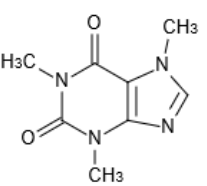
Figure 1. Caffeine chemical structure. Figure 1. Ca ff eine chemical